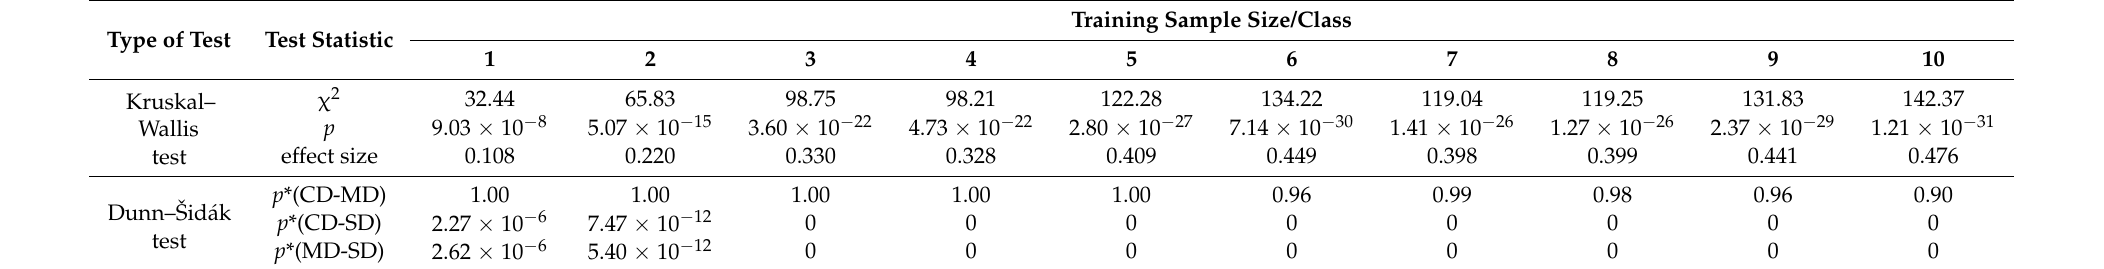
Table A1. Results of the Kruskal–Wallis test and the Dunn–Šidak post hoc test for the kNN algorithm ( α = 0.05).